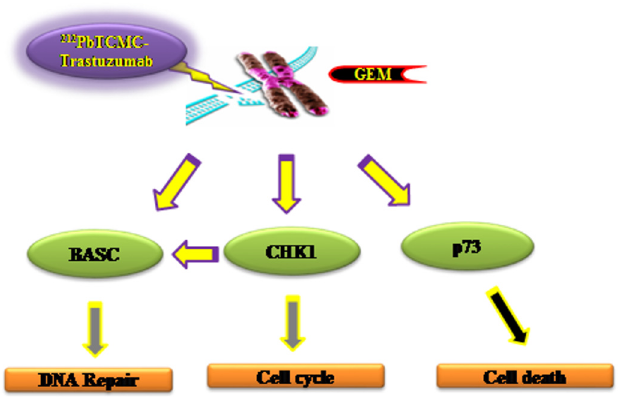
Fig 3. Interplay between DNA damage repair and check point signaling in the stressful growth arrest conditions by Gem/ 212 Pb-trastuzumab. See text for details.